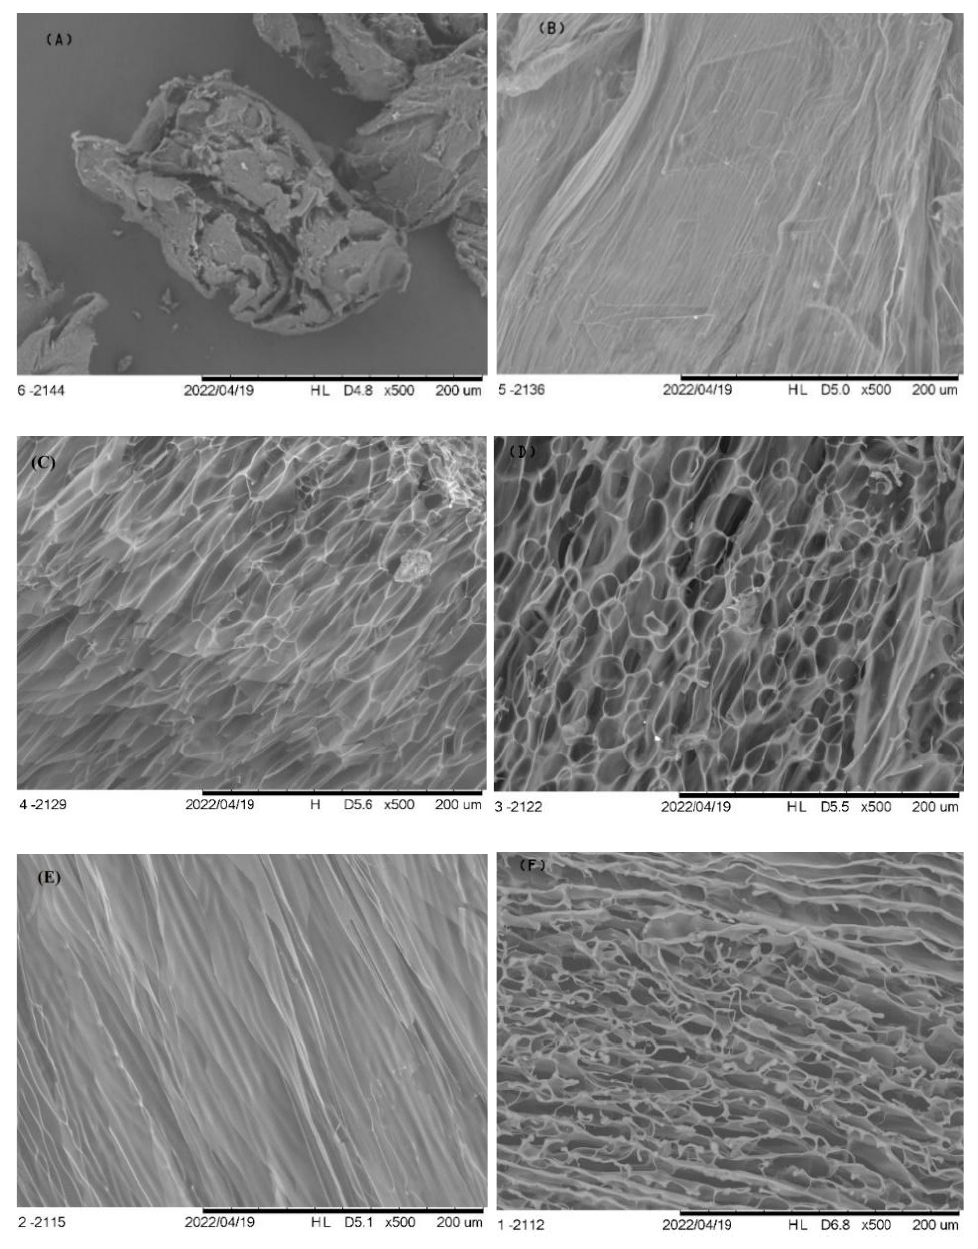
Figure 1. Scanning electron micrography of freeze-dried chitosan solutions prepared with 0.0 ( A ), 0.2 ( B ), 0.4 ( C ), 0.6 ( D ), 0.8 ( E ), and 1.0% ( F ) of acetic acid solutions.